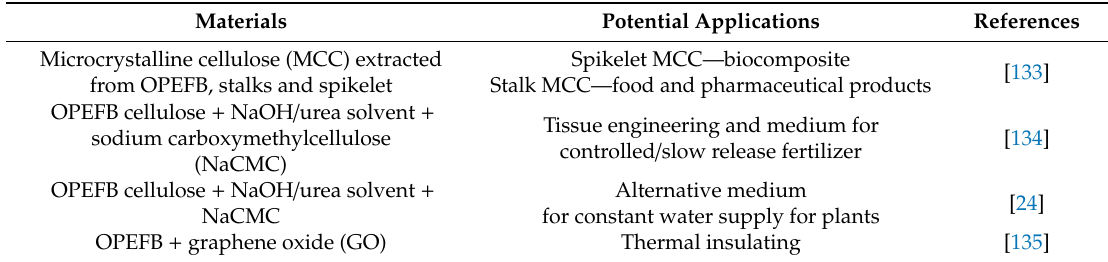
Table 3. Hydrogel made from the OPEFB cellulose and its potential applications.